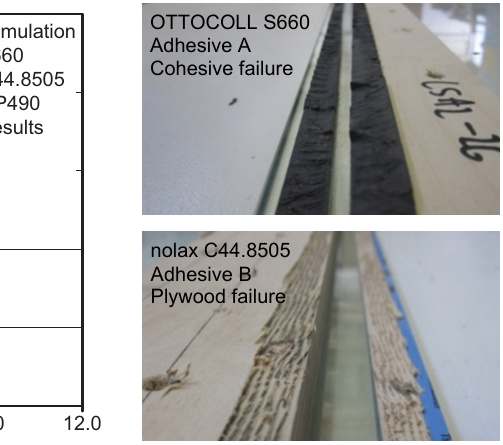
Fig. 11: Representative load-displacement relation from mid-size shear tests on three different adhesives